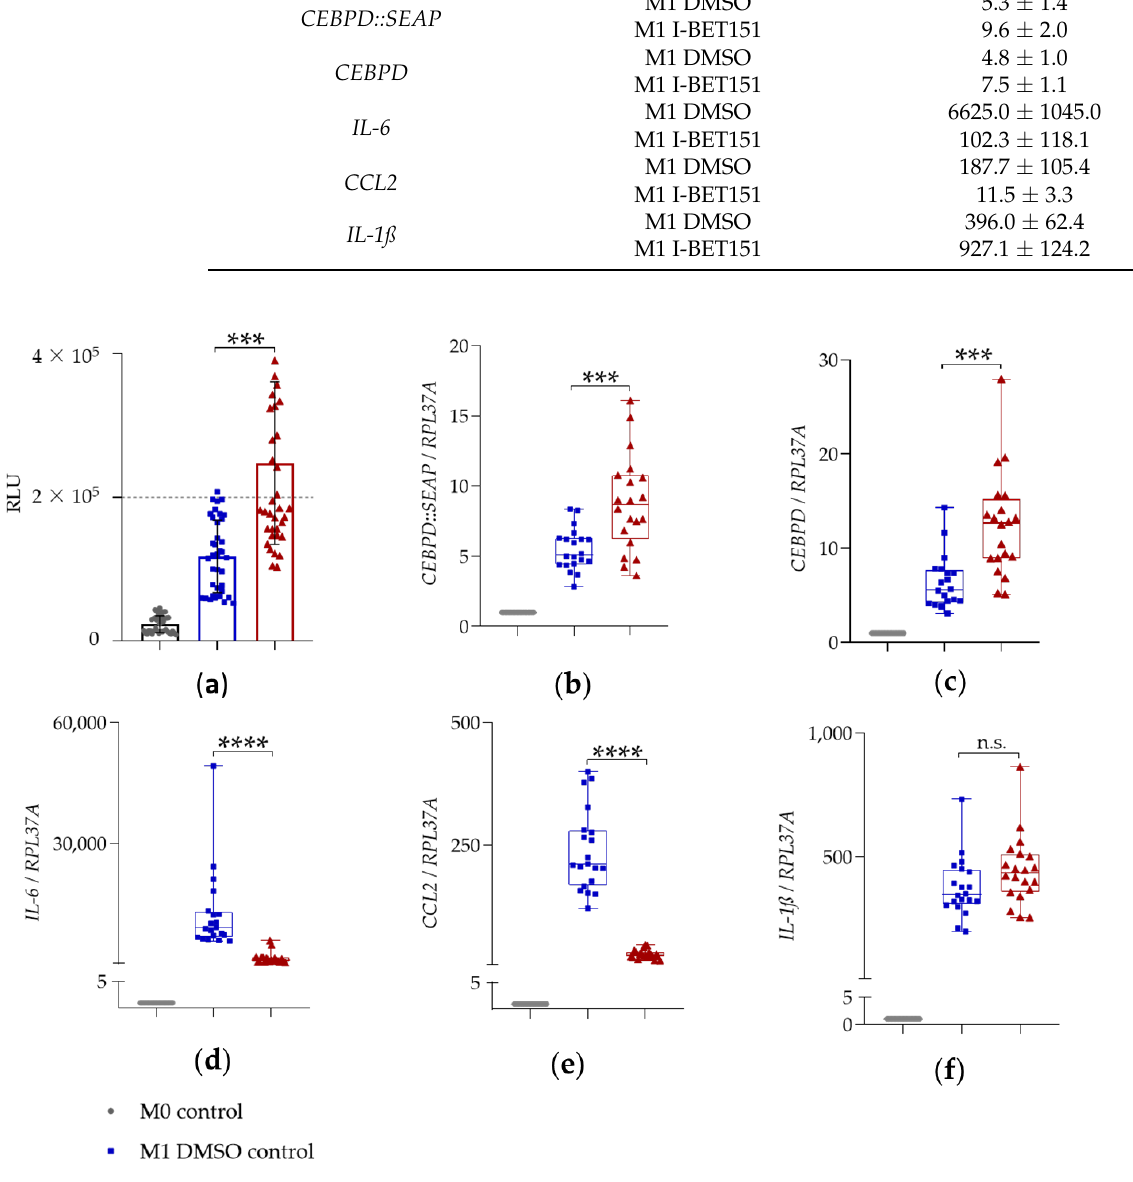
Figure 5. The effect of BET inhibitor Ro 11-1464 on SEAP secretion and mRNA expression. In ( a ), PMA-differentiated THP-1 reporter M φ were pre-treated with 10 µ M Ro 11-1464 for 1 h and stimulated with 0.1 µ g/mL LPS + 20 ng/mL IFN- γ for 24 h for SEAP assay (mean ± SD, n = 5 with 4 wells per condition). Changes in SEAP enzymatic activity were analyzed relative to M1 DMSO control via Kruskal–Wallis test with Dunn’s correction for multiple comparisons. *** p < 0.001. In ( b – f